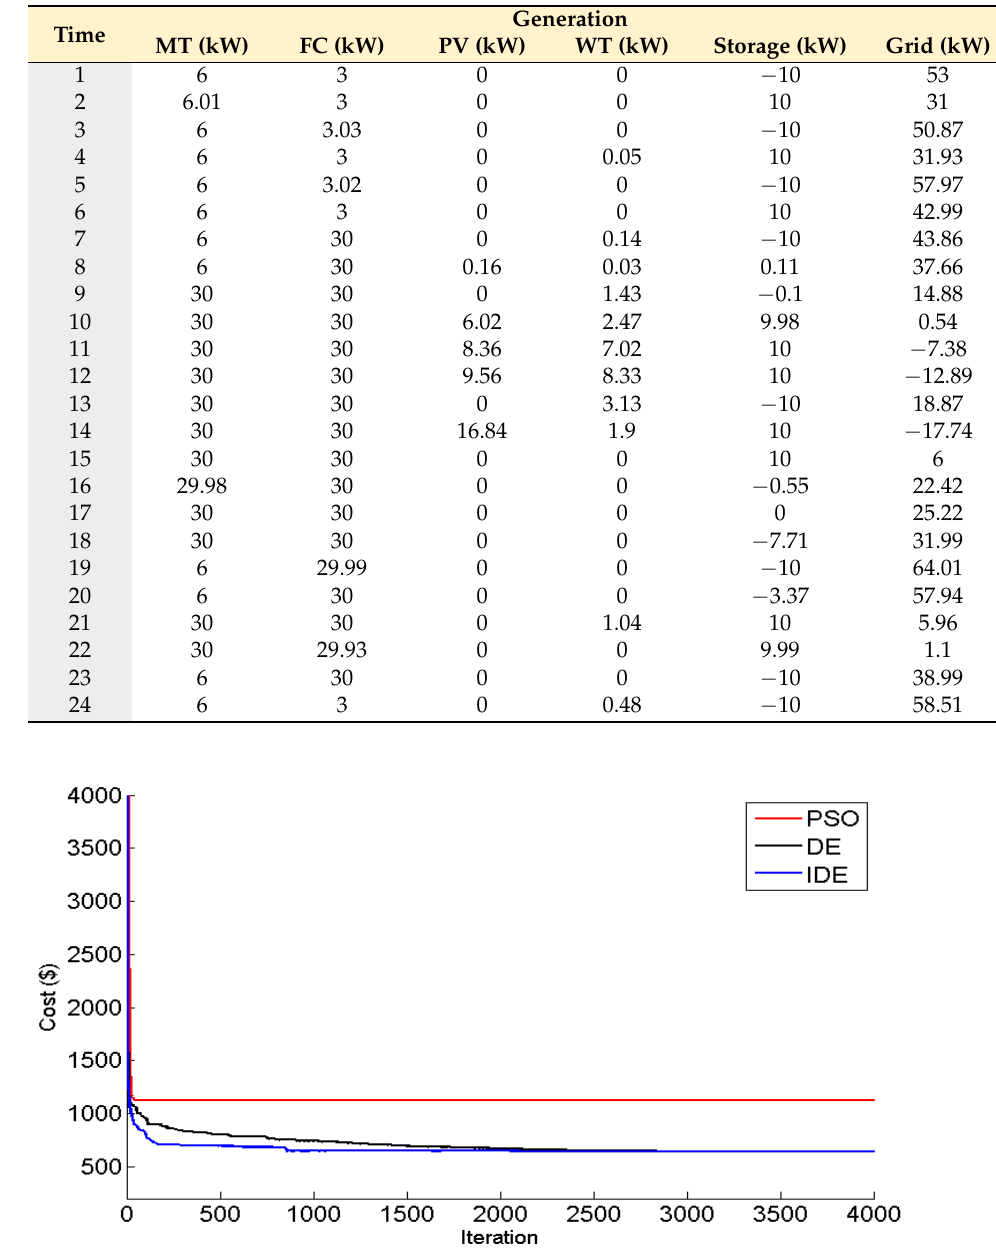
Figure 3. Convergence diagram of emission in different methods without considering the limita- tions of upstream power exchange.